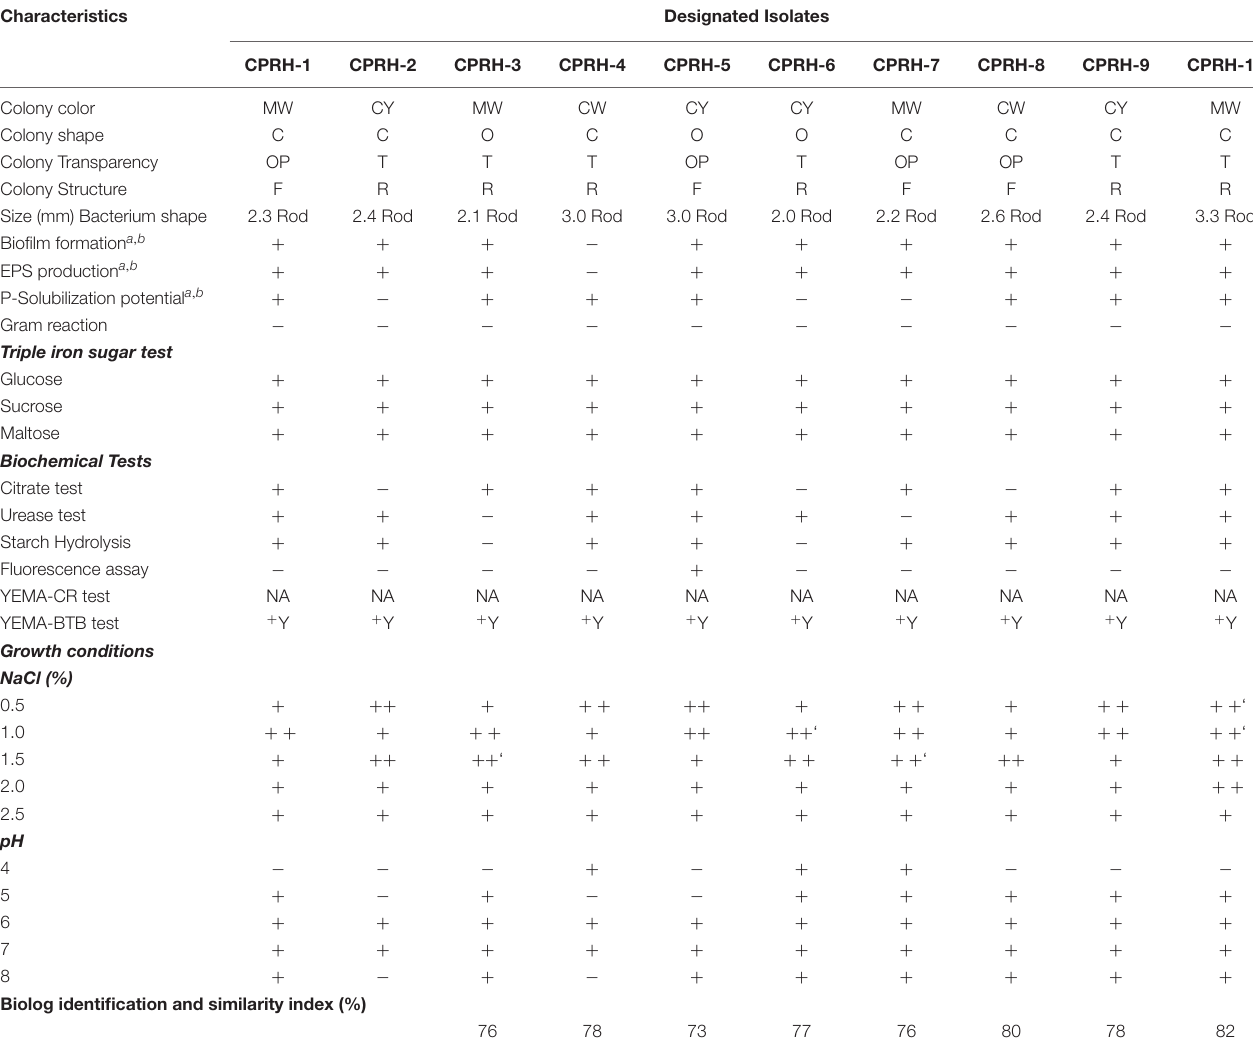
TABLE 1 | Physiological, biochemical, and plant growth-promoting factors of chickpea nodule rhizobia.